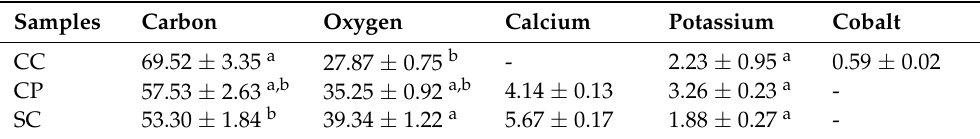
Figure 3. The SEM micrographs of lignocellulosic biomasses; including corn cob (CC), cornstalk piths (CP) and sugarcane bagasse (SC). Table 2. Element analysis (mass %) of lignocellulosic biomasses, including corn cob (CC), cornstalk piths (CP) and sugarcane bagasse (SC) using Energy Dispersive X-ray spectroscopy (EDX). Means with different letters ( a , b ) within each column indicate statistically significant differences between the samples after Duncan’s analysis ( p < 0.05). Post-hoc tests were not performed if there were fewer than three